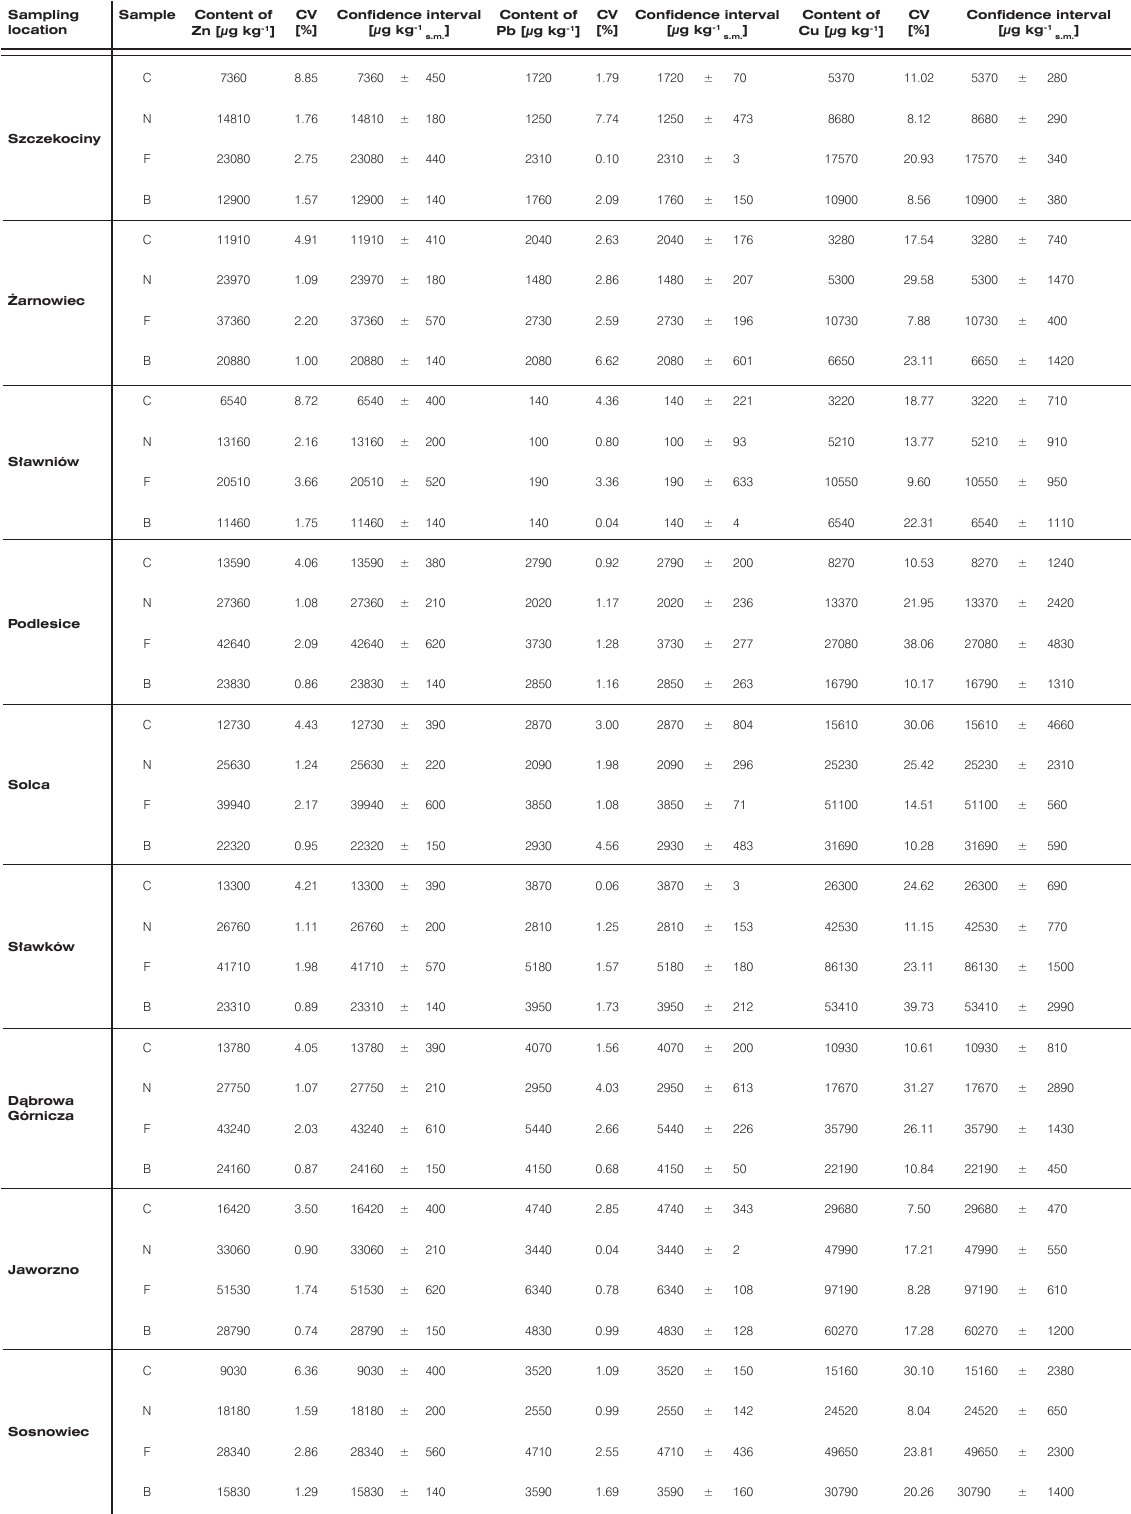
Table 2. Average content of the indicated metals in the respective sampling locations. Sampling